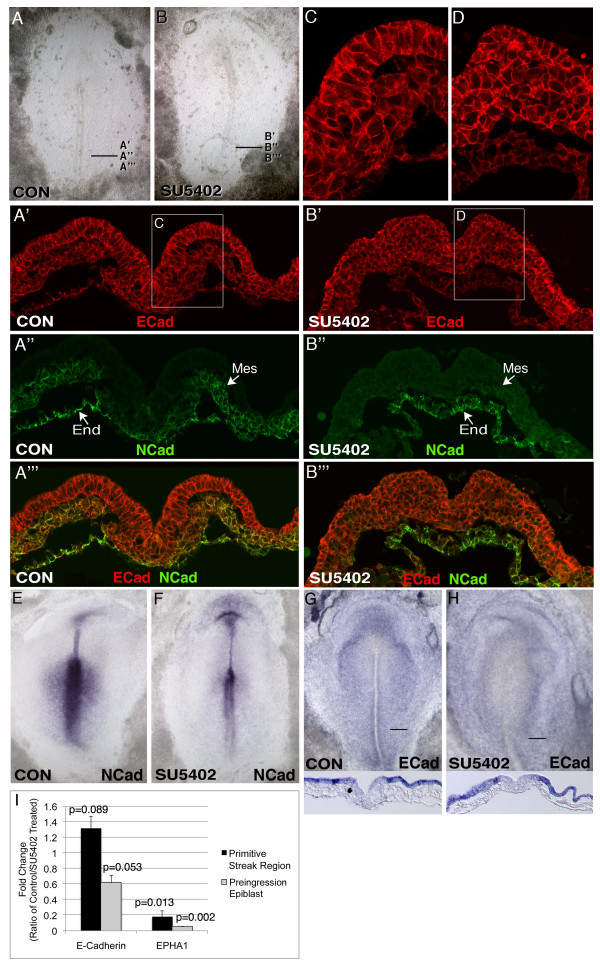
E- and N-cadherin expression in control and SU5402 treated embryos. A-B: Brightfield images of control (A) and SU5402 treated (B) embryos that were processed for immunofluorescence analysis of E-cadherin (ECad) and N-cadherin (NCad). A'-A'": transverse section showing the same microscopic field at the indicate streak level of the control embryo in A, visualizing E-cadherin protein (A'), N-cadherin protein (A"), and E-cadherin plus N-cadherin (A'"). B'-B'": transverse section showing the same microscopic field at the indicate streak level of the SU5402 treated embryo in B, visualizing E-cadherin protein (B'), N-cadherin protein (B"), and E-cadherin plus N-cadherin (B'"). C-D: higher magnification views of the boxed areas in A' and B'. E-H: Whole mount ISH visualization of N-cadherin (E, F) and E-cadherin (G, H) mRNAs in control and SU5402 treated embryos. I: Realtime RT-PCR analysis showing relative E-cadherin and EPHA1 mRNA levels in control versus SU5402 treated primitive streak region (preingression epiblast, primitive streak, medial mesoderm) and isolated preingression epiblast. Error bars indicate standard deviation. Abbreviations: Mes, mesoderm; End, endoderm.